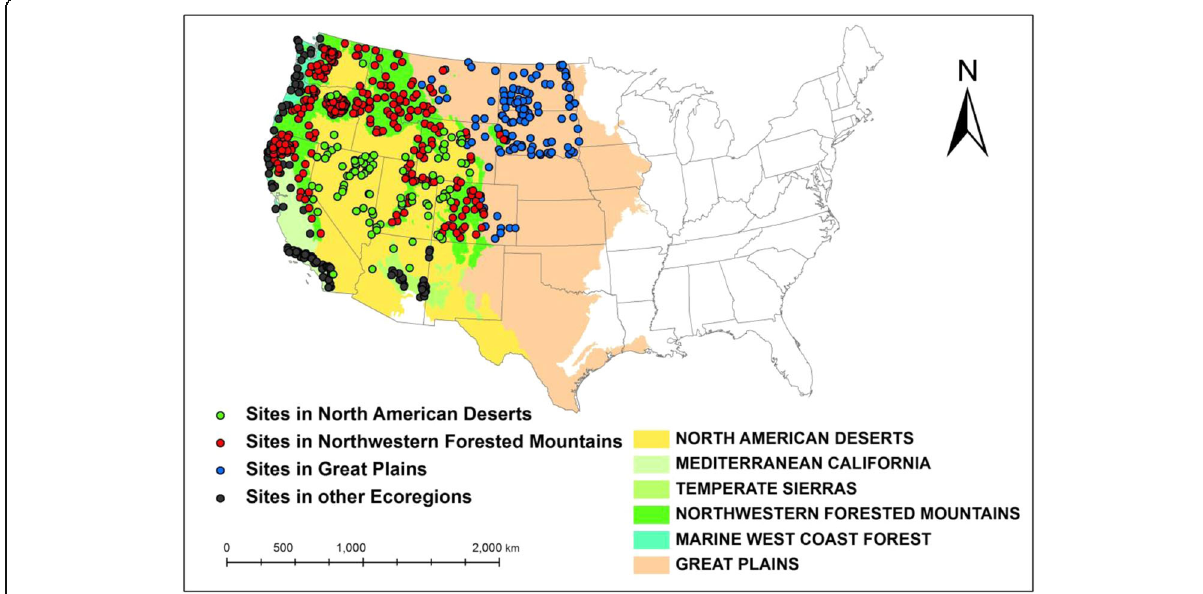
Fig. 1 The sampled stream sites as well as their associated level I ecoregions defined by USEPA. Three subsets (strata) were extracted for analysis: the Great Plains ’ streams (blue points), the Northwestern Forested Mountains ’ streams (red points), and the North American Deserts ’ streams (green points)